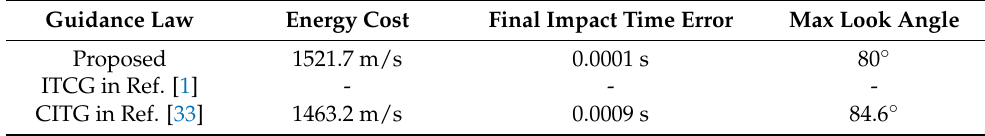
Table 8. Characteristics for T d = 90